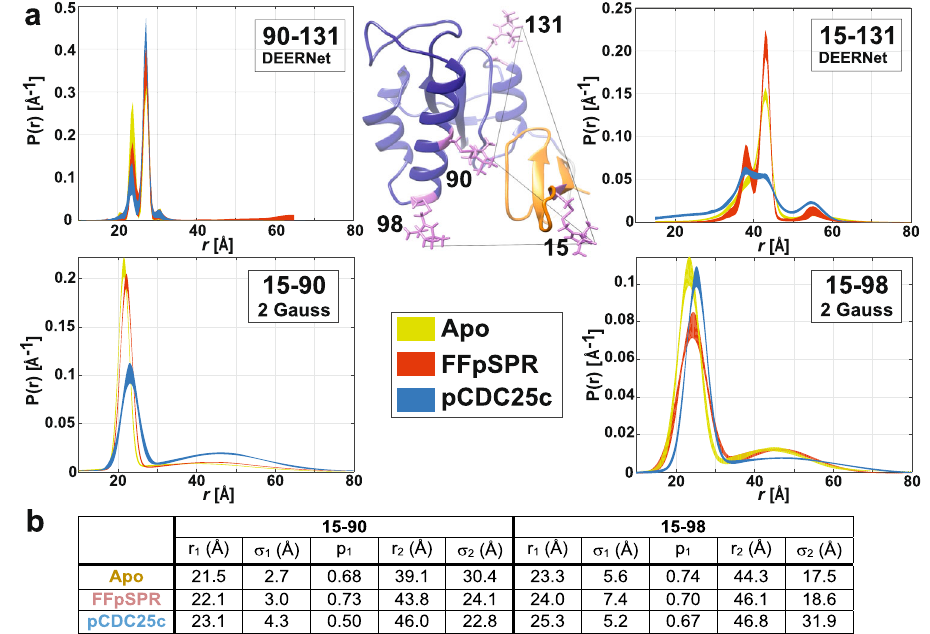
Fig. 2 | Impact of ligand binding on the DEER distance distributions of Pin1. a DEER distributions are plotted including 95% con fi dence intervals for each con- struct obtained from either a DEERNet neural network analysis or bi-Gaussian fi t. Apo, FFpSPR- and pCDC25c-bound Pin1 data is plotted in yellow, red and blue, respectively. MTSL positions (pink) and distances (black) are drawn onto the WW